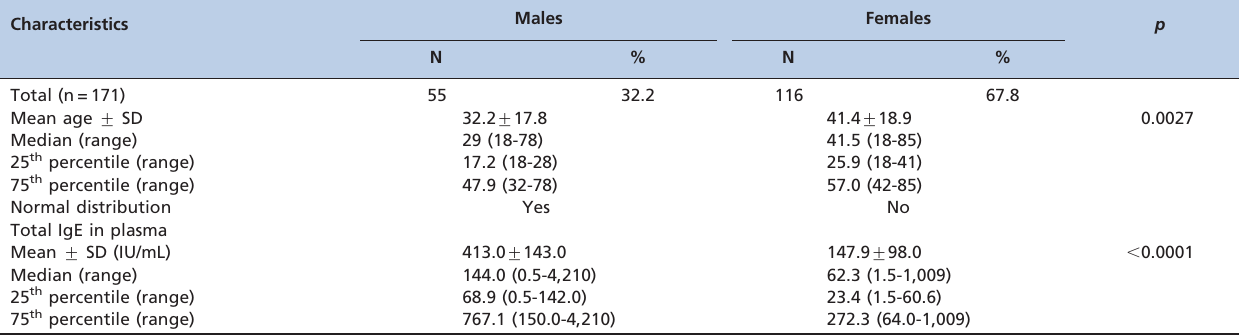
Table 1 - Mean age and mean values of total IgE plasma levels between male and female patients with allergic rhinitis.